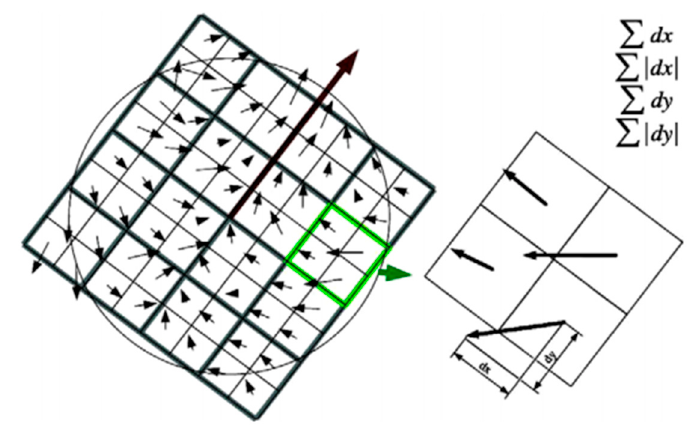
Figure 11. Description of the interest point.